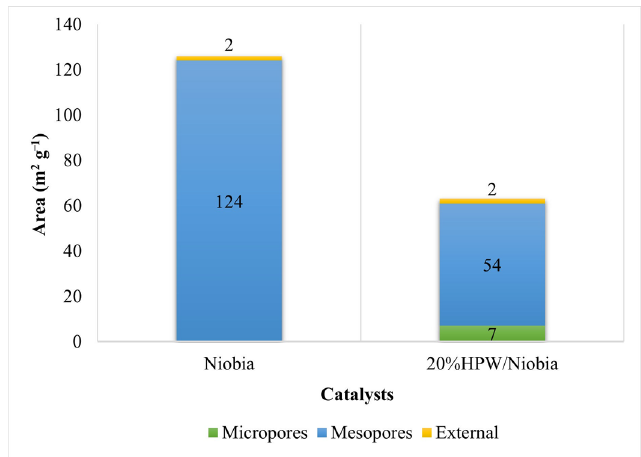
Figure 3. Distribution of specific surface areas of the niobia-based catalysts.